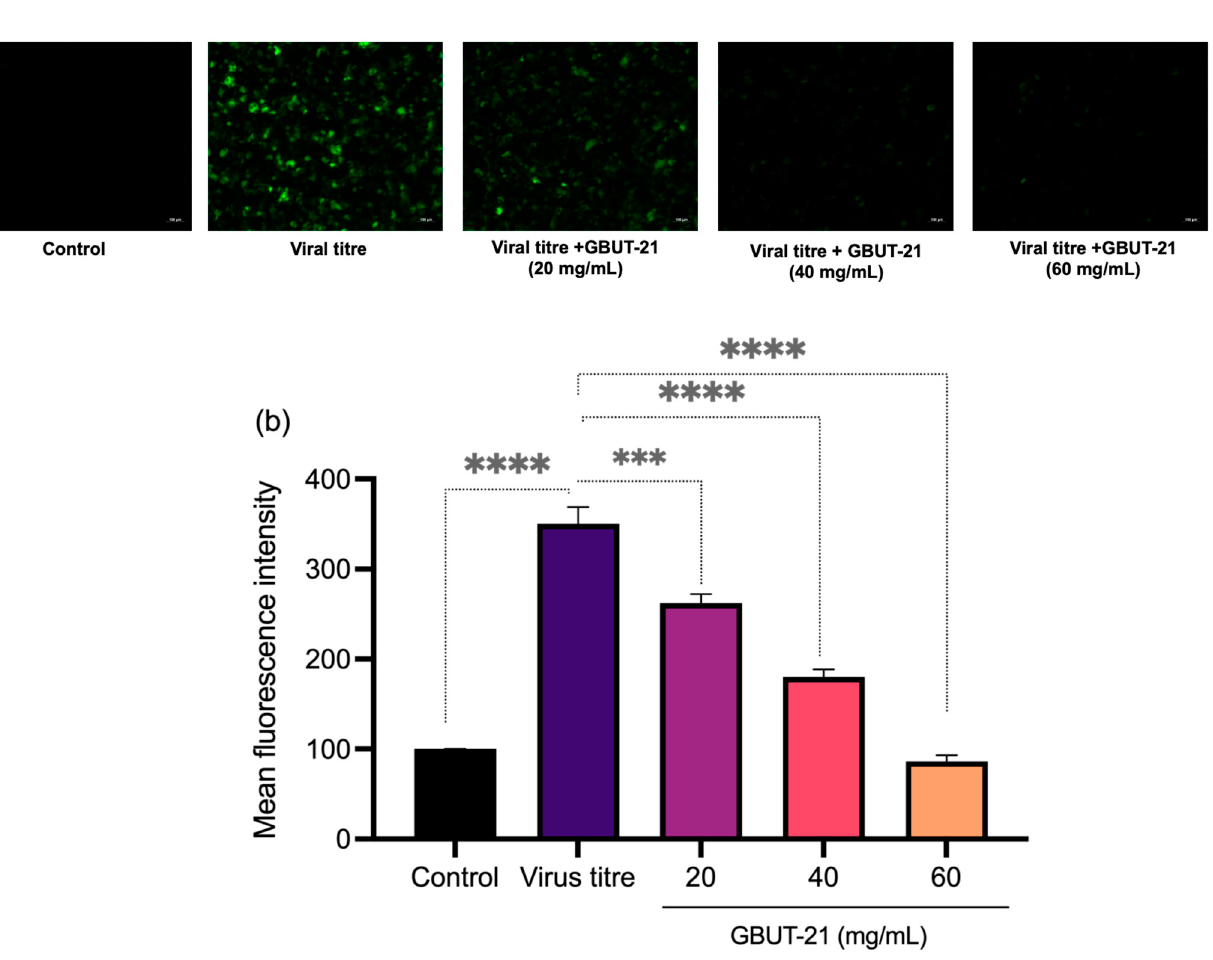
Figure 3. ROS staining via H2DCFDA staining. Treatment cells were stained with H2DCFDA stain for 30 min and PBS washes were further given to get final fluorescence images under fluorescence microscope. ( a ) Fluorescence images. ( b ) Depicting mean fluorescence intensity. An asterisk ( p < 0.05) indicates values that are significantly different from the control. Bars depict mean ± SD of three independent experiments. **** p < 0.0001, *** p < 0.001 vs. virus